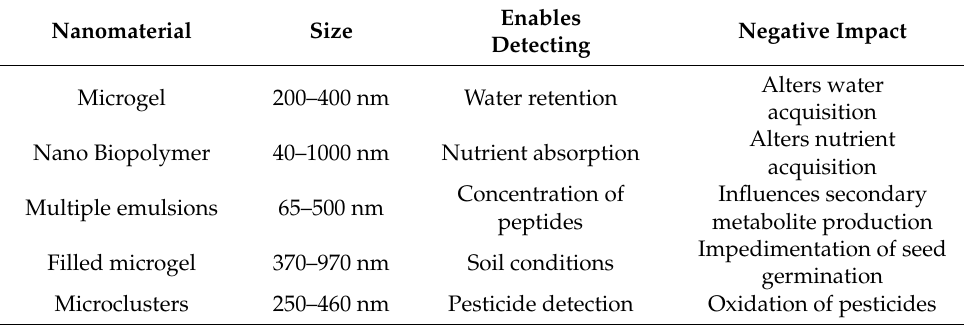
Table 2. Detecting ability and negative impact of nanomaterial used in sensors.